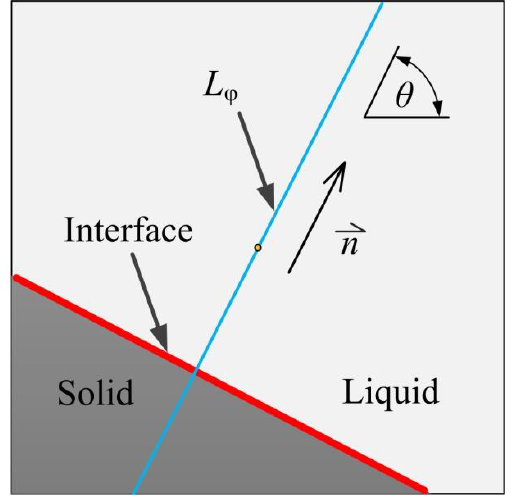
Figure 1. Physical model of the solid-liquid interface.